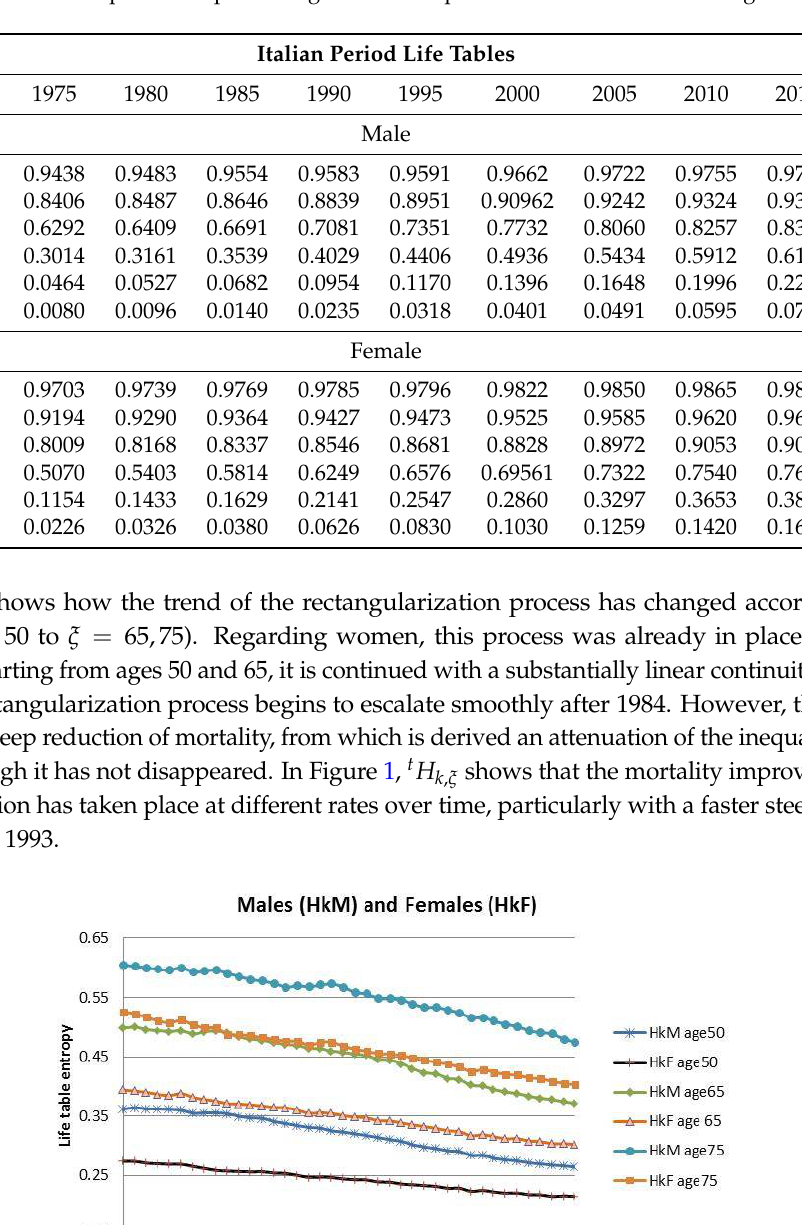
Table 1. Proportion of persons aged 30 and expected to be alive at selected ages.